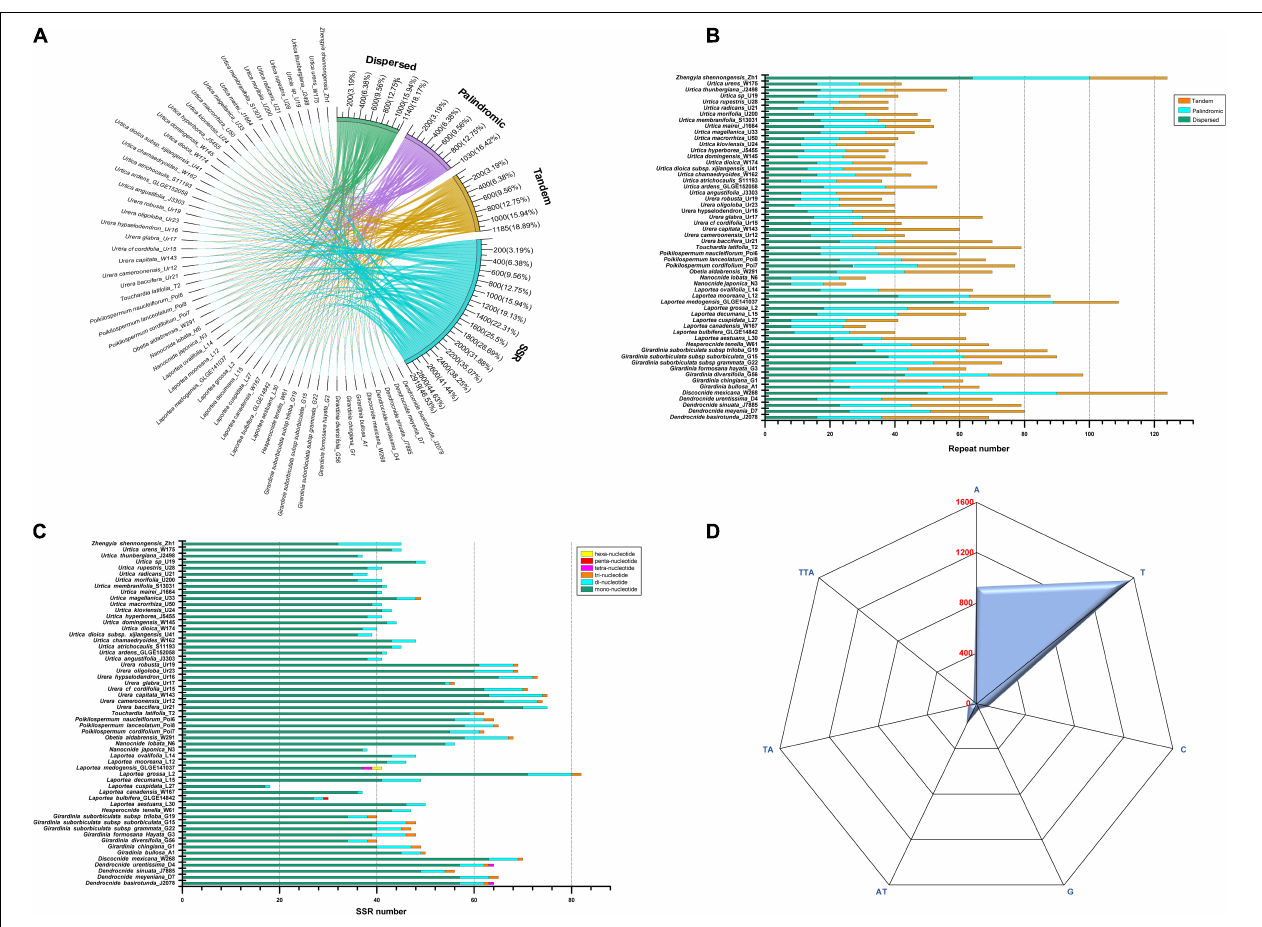
FIGURE 4 | (A) Chord diagram showing a connection between species and their corresponding repeat types (Dispersed, Palindromic, Tandem, and SSR). The tick marks beside each repeat type indicate the frequency of the number of repeats detected and their percentages, respectively; (B) frequency of tandem, palindromic, and dispersed repeats; (C) number of the six SSR(simple sequence repeats) nucleotides; (D) the seven most abundant SSR motifs in Urticeae plastomes. The values along the axis represent the abundance values.